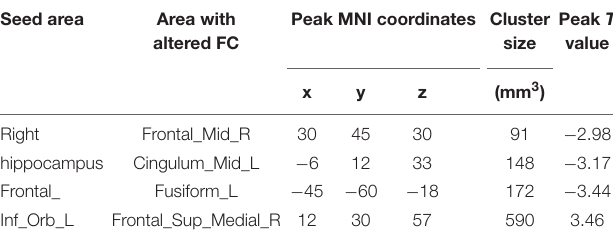
TABLE 3 | Significant differences in functional connectivity between postpartum depression (PPD) and healthy controls (HCs). Seed